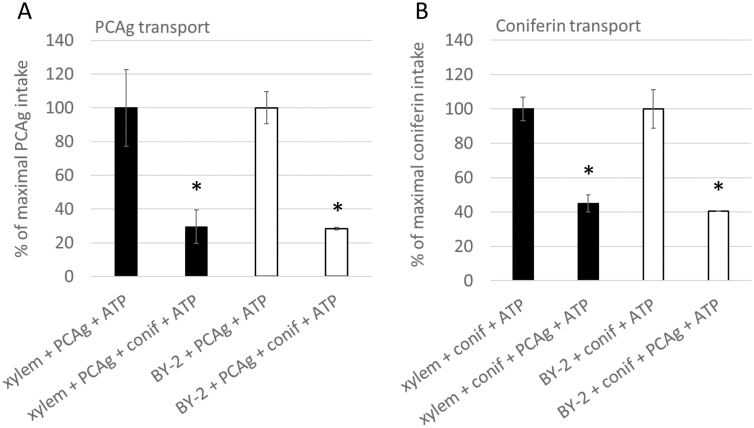
Inhibition of ATP-dependent uptake of (A) p-coumaryl alcohol glucoside (PCAg) and (B) 14C-coniferin (conif) to microsomal vesicles prepared from Norway spruce developing xylem (black bars) and tobacco BY-2 cells (white bars). Inhibition was achieved with equal concentrations (100 µM) of substrates in the reaction mixture. Data presented are means ±SD, n = 3. Asterisks indicate statistically significant transport inhibition (P<0.05; one-tailed Student’s t-test).